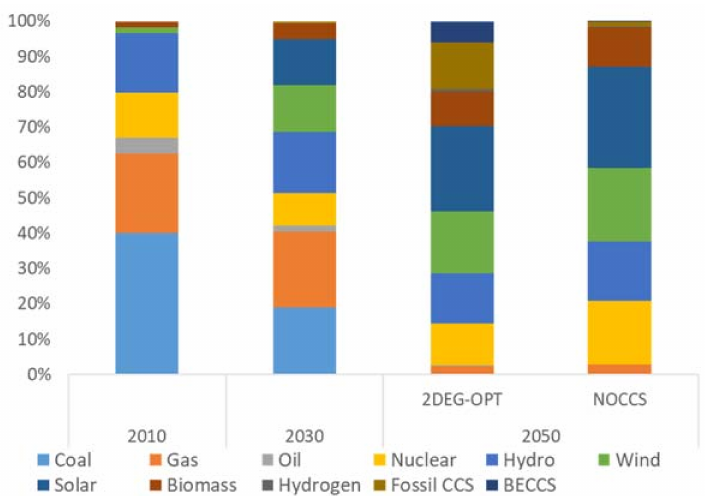
Figure 5. Global power generation mix by technology over 2010–2050 (in %).